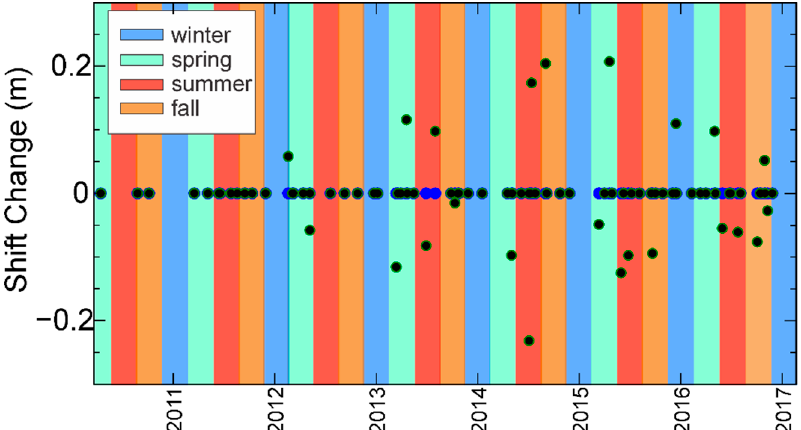
Figure 5. Shift values plotted with hydrograph data in Skunk River at Merrimac. Black, green, and blue dots represent the shift values applied to the section, channel, and overbank control areas, respectively.